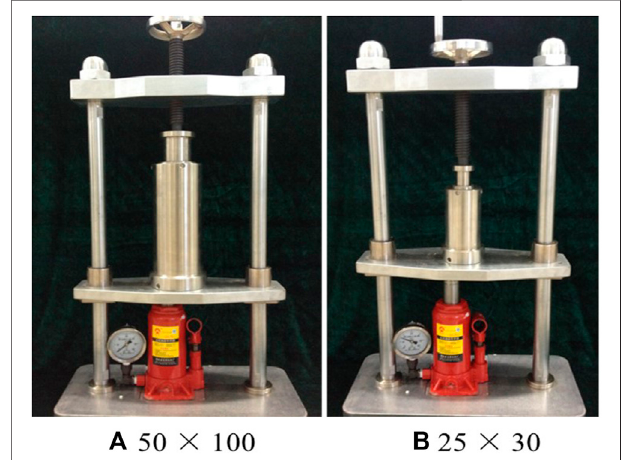
FIGURE 2 | Manual grouting equipment. (A) 50 × 100, (B) 25